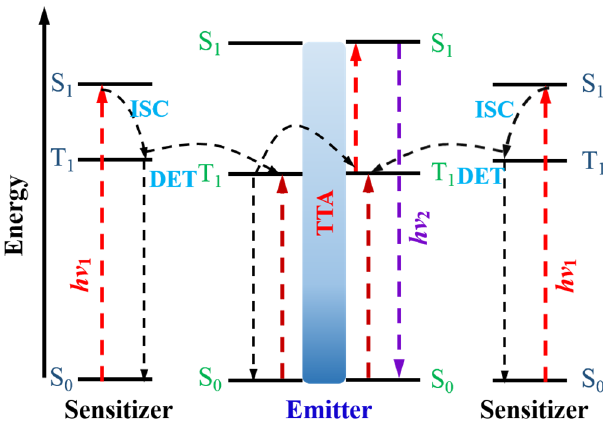
Figure 4. The working principle of the triplet-triplet annihilation